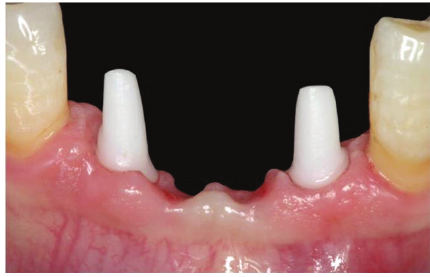
Figure 7: Soft tissue health 6 months after surgery.